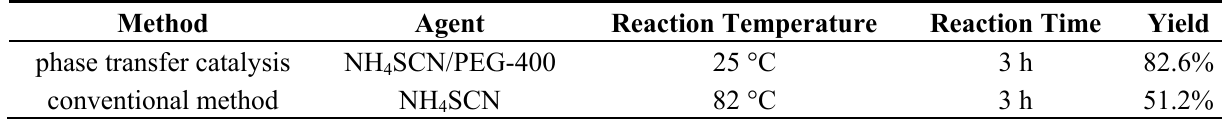
Table 1. Phase transfer catalysis compared with conventional method for 6a